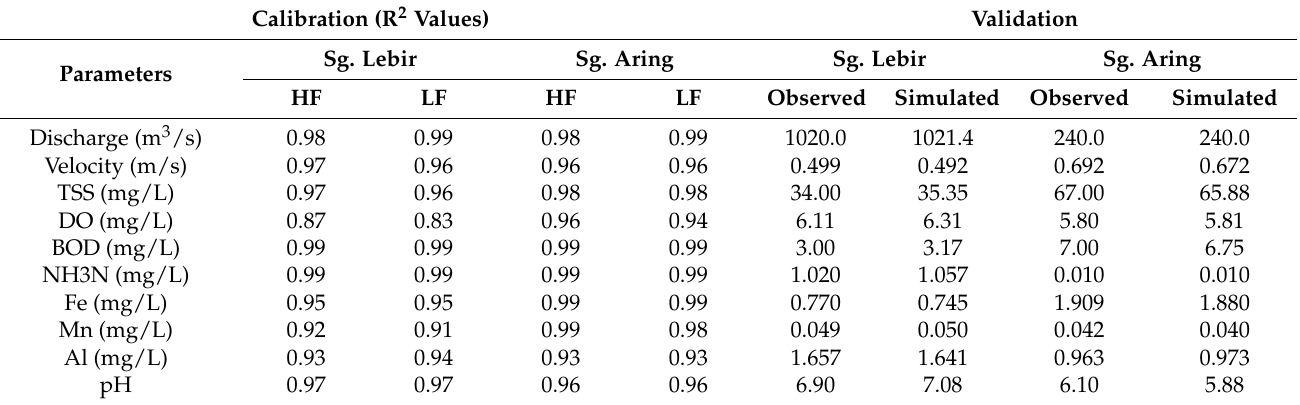
Table 4. Summary of calibration and validation results. HF and LF are high and low flows, respectively. Calibration (R 2 Values)